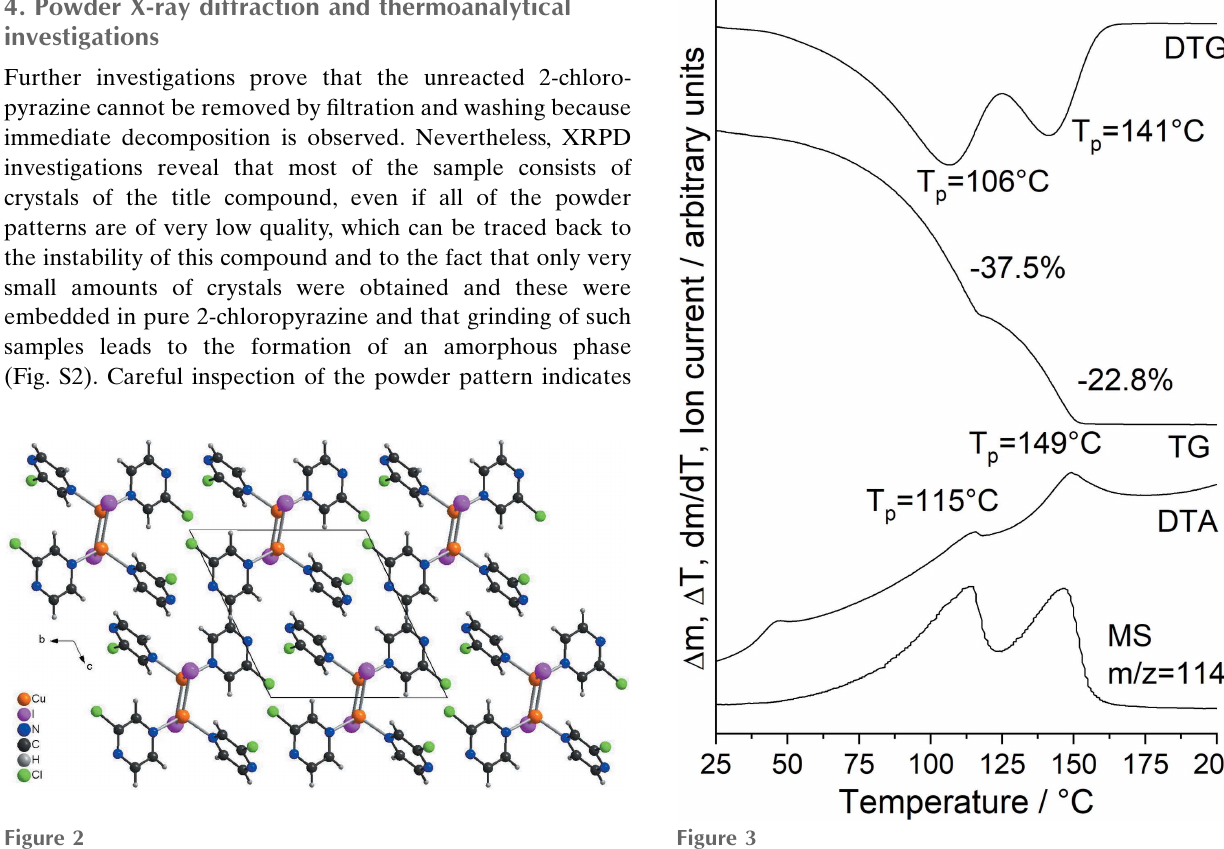
Figure 3 DTG, TG, DTA and MS trend scan curves for the title compound measured with a heating rate of 4 (cid:5) C min (cid:3) 1 .